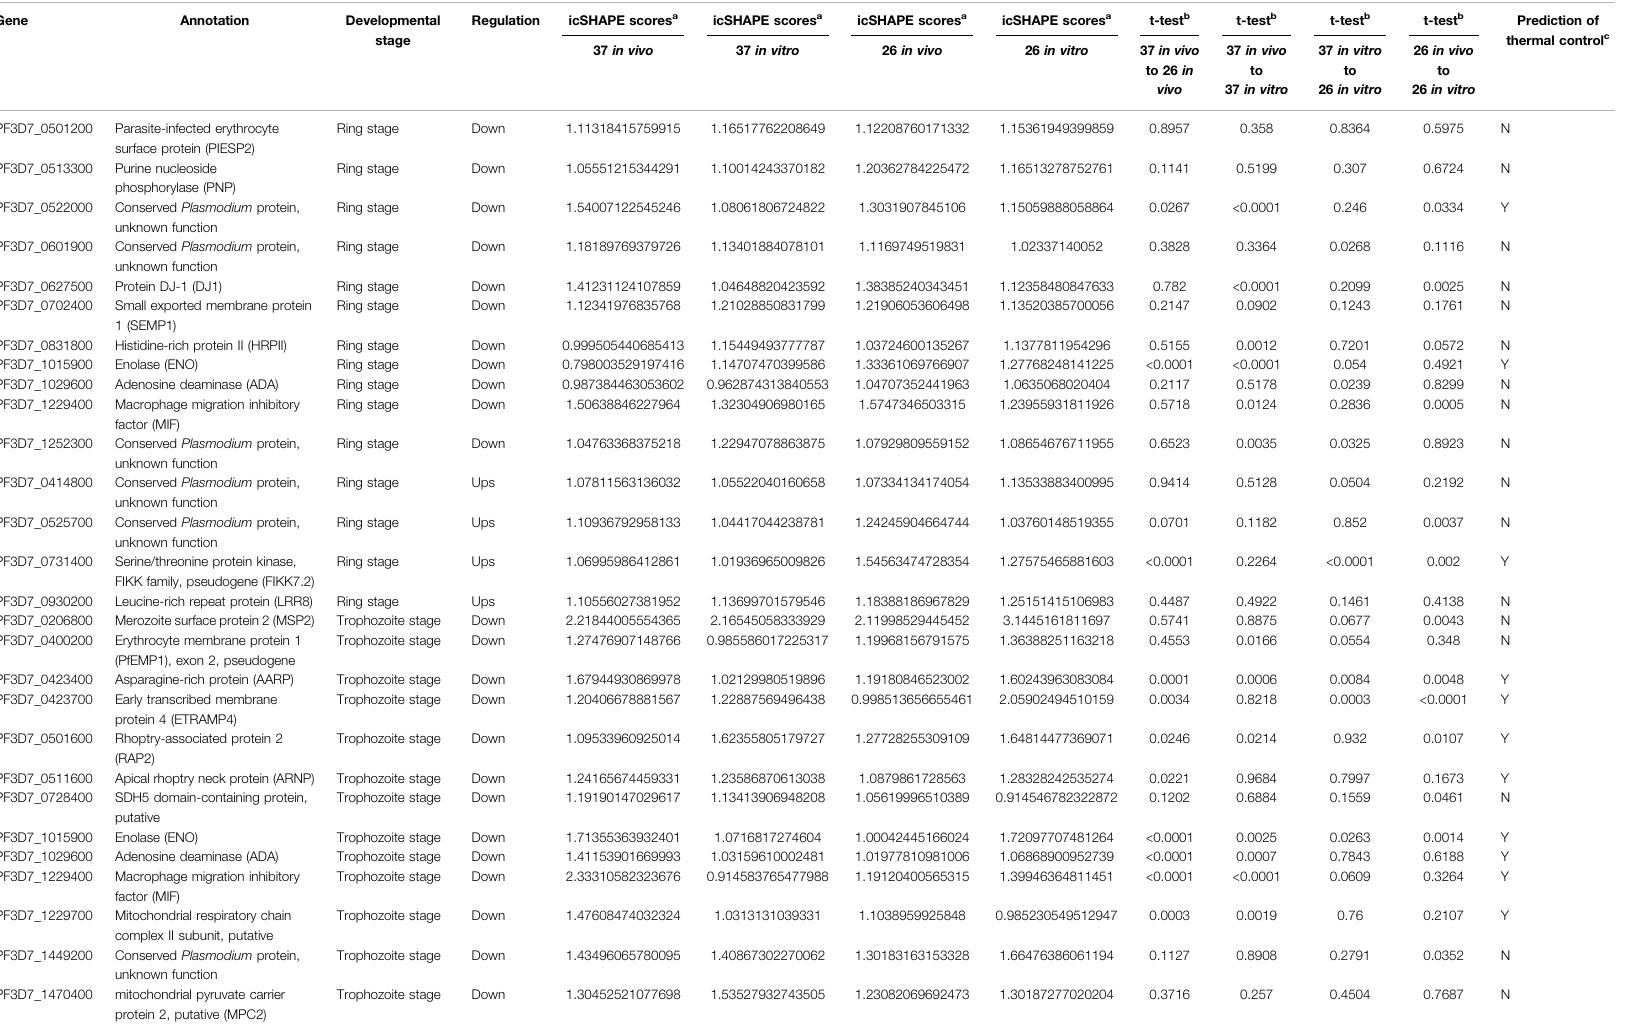
TABLE 1 | List of the RNAT candidates according to cold stress in Plasmodium [columns show, for each gene, the name, annotation developmental stage, regulation, t -test, and average of icSHAPE scores of 5 ′ -UTR ( − 1 to − 200)].